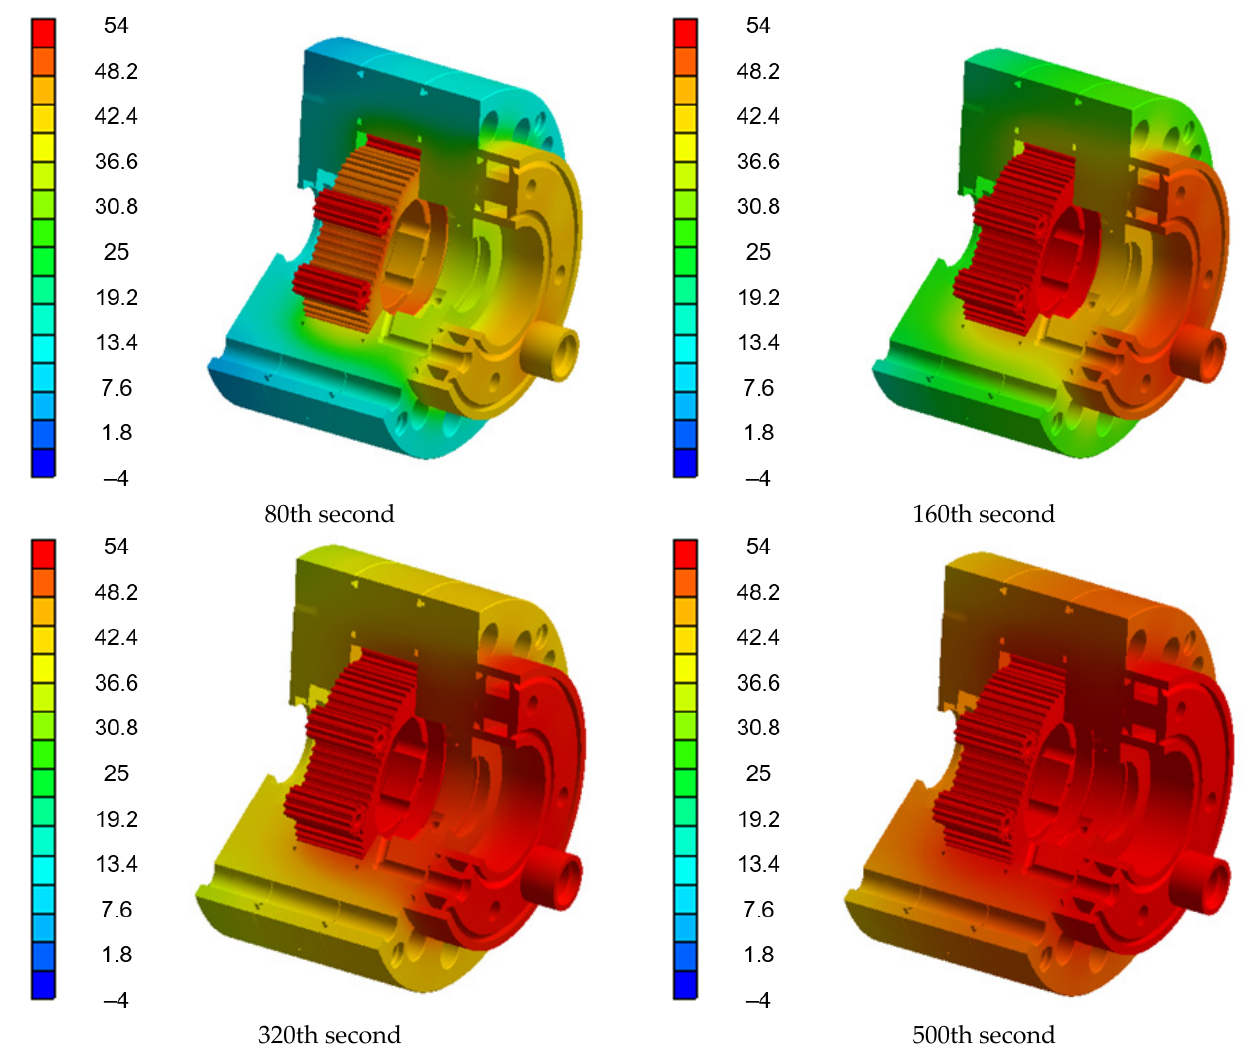
Figure 18. Temperature distribution in warmed-up elements of M1 satellite motor (initial motor temperature − 4 °C, rotational speed in the steady-state conditions 185 rpm) at the 5th, 10th, 20th, 40th, 80th, 160th, 320th, and 500th second after supplying with 54 °C warm oil. Satellites heat up the fastest due to their low mass and large heat transfer surface.